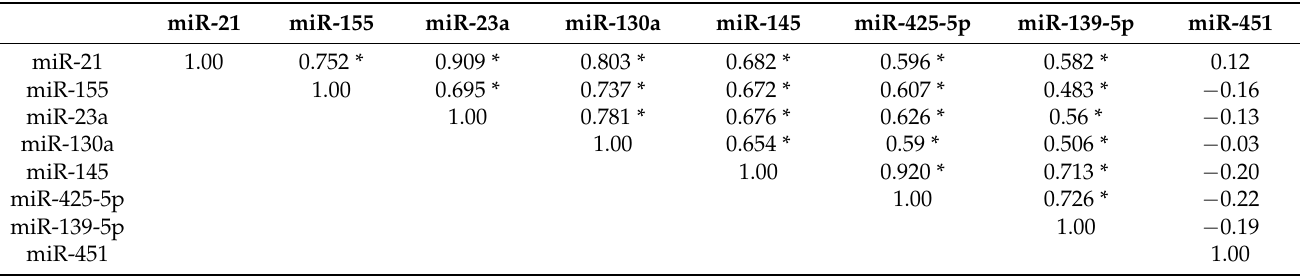
Table 3. Spearman’s correlation coefficients between each pair of miRNAs. * denotes significant correlation coefficient ( p -value < 0.05).